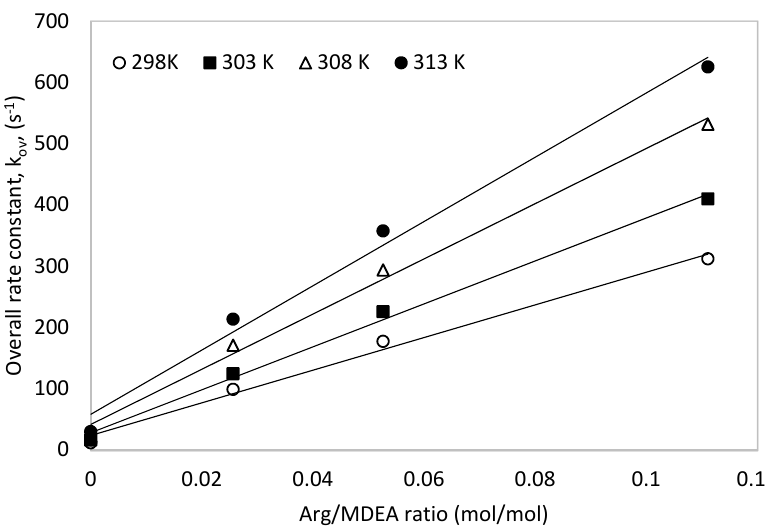
Figure 6. Overall rate constant, ‘k ov ’, vs. different Arg/MDEA ratios for a total 1 M solution.